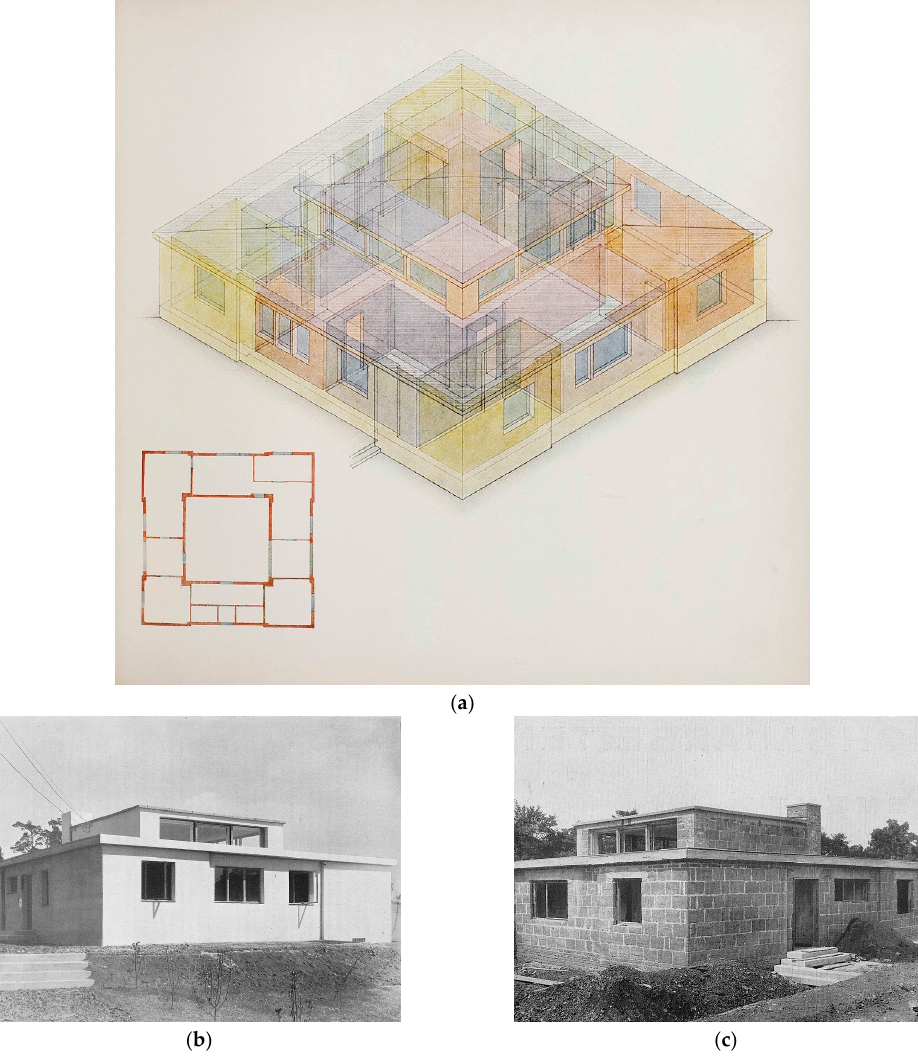
Figure 8. Georg Muche: Experimental house Am Horn, Weimar, 1923—Conceptual diagram, photo and construction site photo. Images taken from (Meyer 1925a, pp. 18, 26) and (Nierendorf 1923, p. 169).